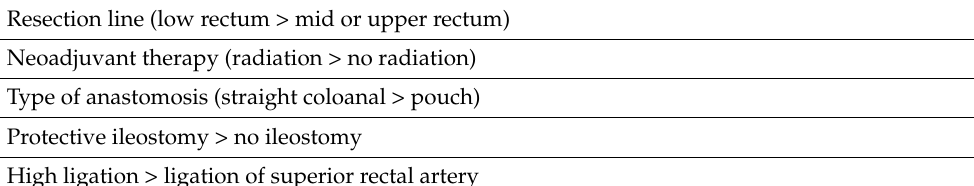
Table 1. Possible risk factors for